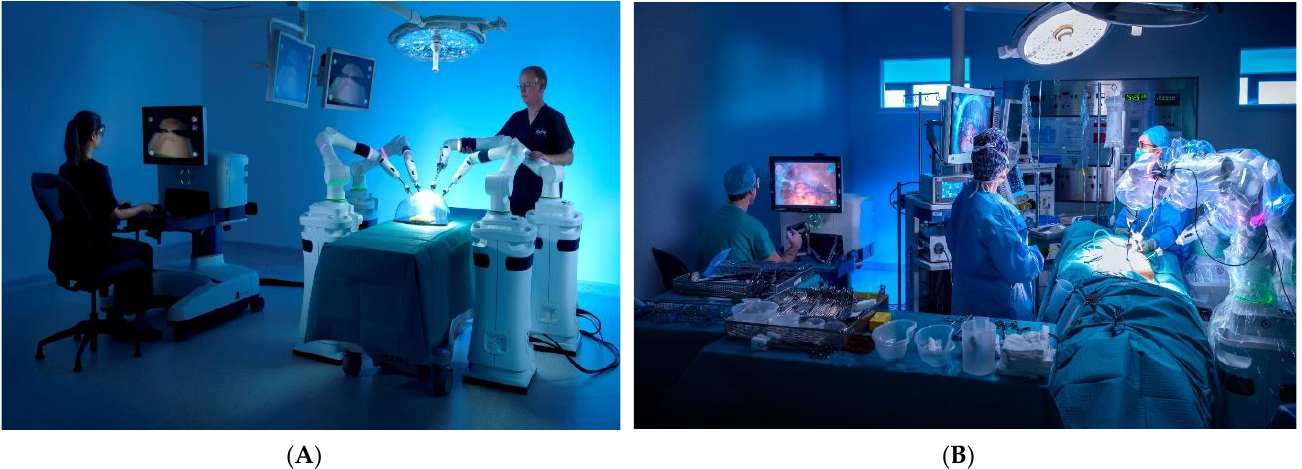
Figure 2. ( A ) Overview of the Versius surgical robotic system in a training setup ( B ) Versius surgical robotic system in OR use.